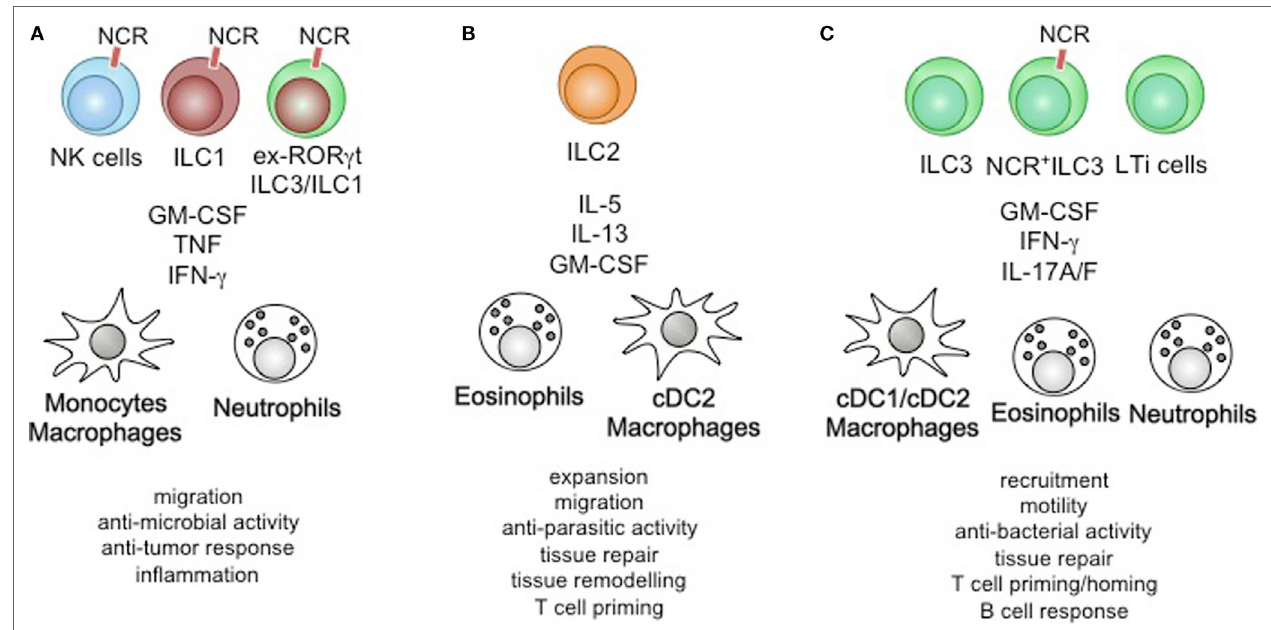
FiGURe 3 | Summary of ILC-mediated myeloid cell activation on immunity and physiology. (A) Natural killer (NK) cells, Group 1 ILCs (ILC1), and ex-ROR γ t ILC3/ ILC1 control the migration of monocyte/macrophages and neutrophils, modulate their anti-microbial activity and anti-tumor response leading to sustained inflammation. (B) ILC2-derived cytokines act on eosinophils, dendritic cells (DCs), and macrophages to control their proliferation, migratory behavior, role in tissue remodeling and repair. Furthermore, ILC2-mediated activation of myeloid cells is essential in anti-parasitic immunity and optimization of Th2 priming. (C) ILC3s control the recruitment, motility, and tissue repair through the activation of DC/macrophages, eosinophils, and neutrophils. The anti-bacterial immunity driven by ILC3-produced cytokines contributes to host-defense, while homeostatic execution of ILC3-specific effector functions improves T cell priming and innate B cell